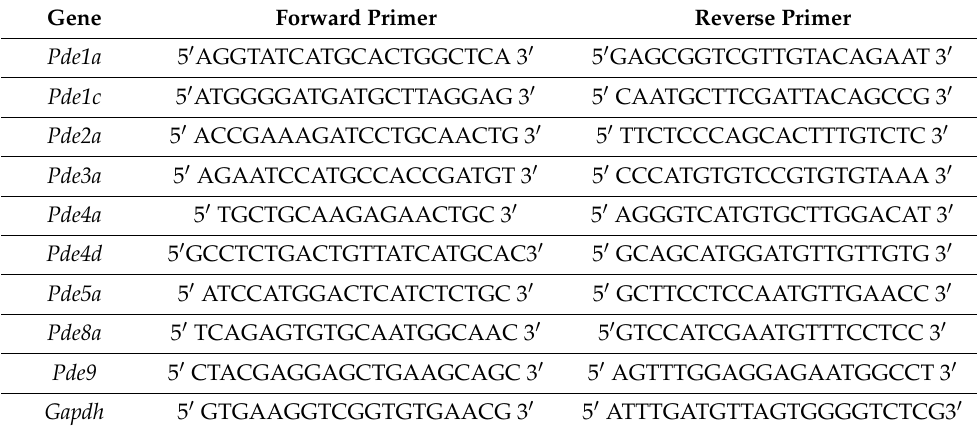
Table 2. qRT-PCR